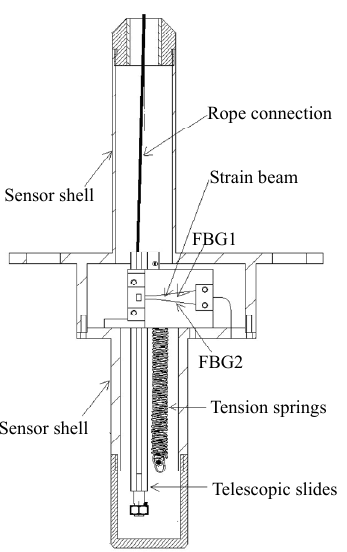
Fig. 1 Schematic of FBG-based displacement